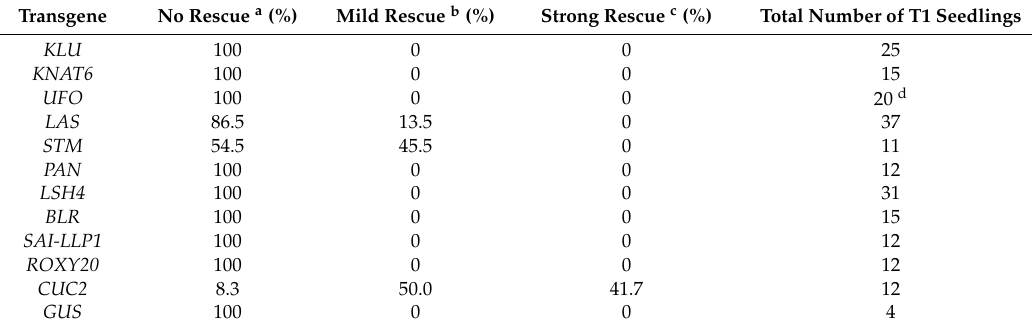
Table 1. Rescue of cuc1 cuc2 seedling phenotype by downstream gene expression under the control of CUC2 regulatory sequence.